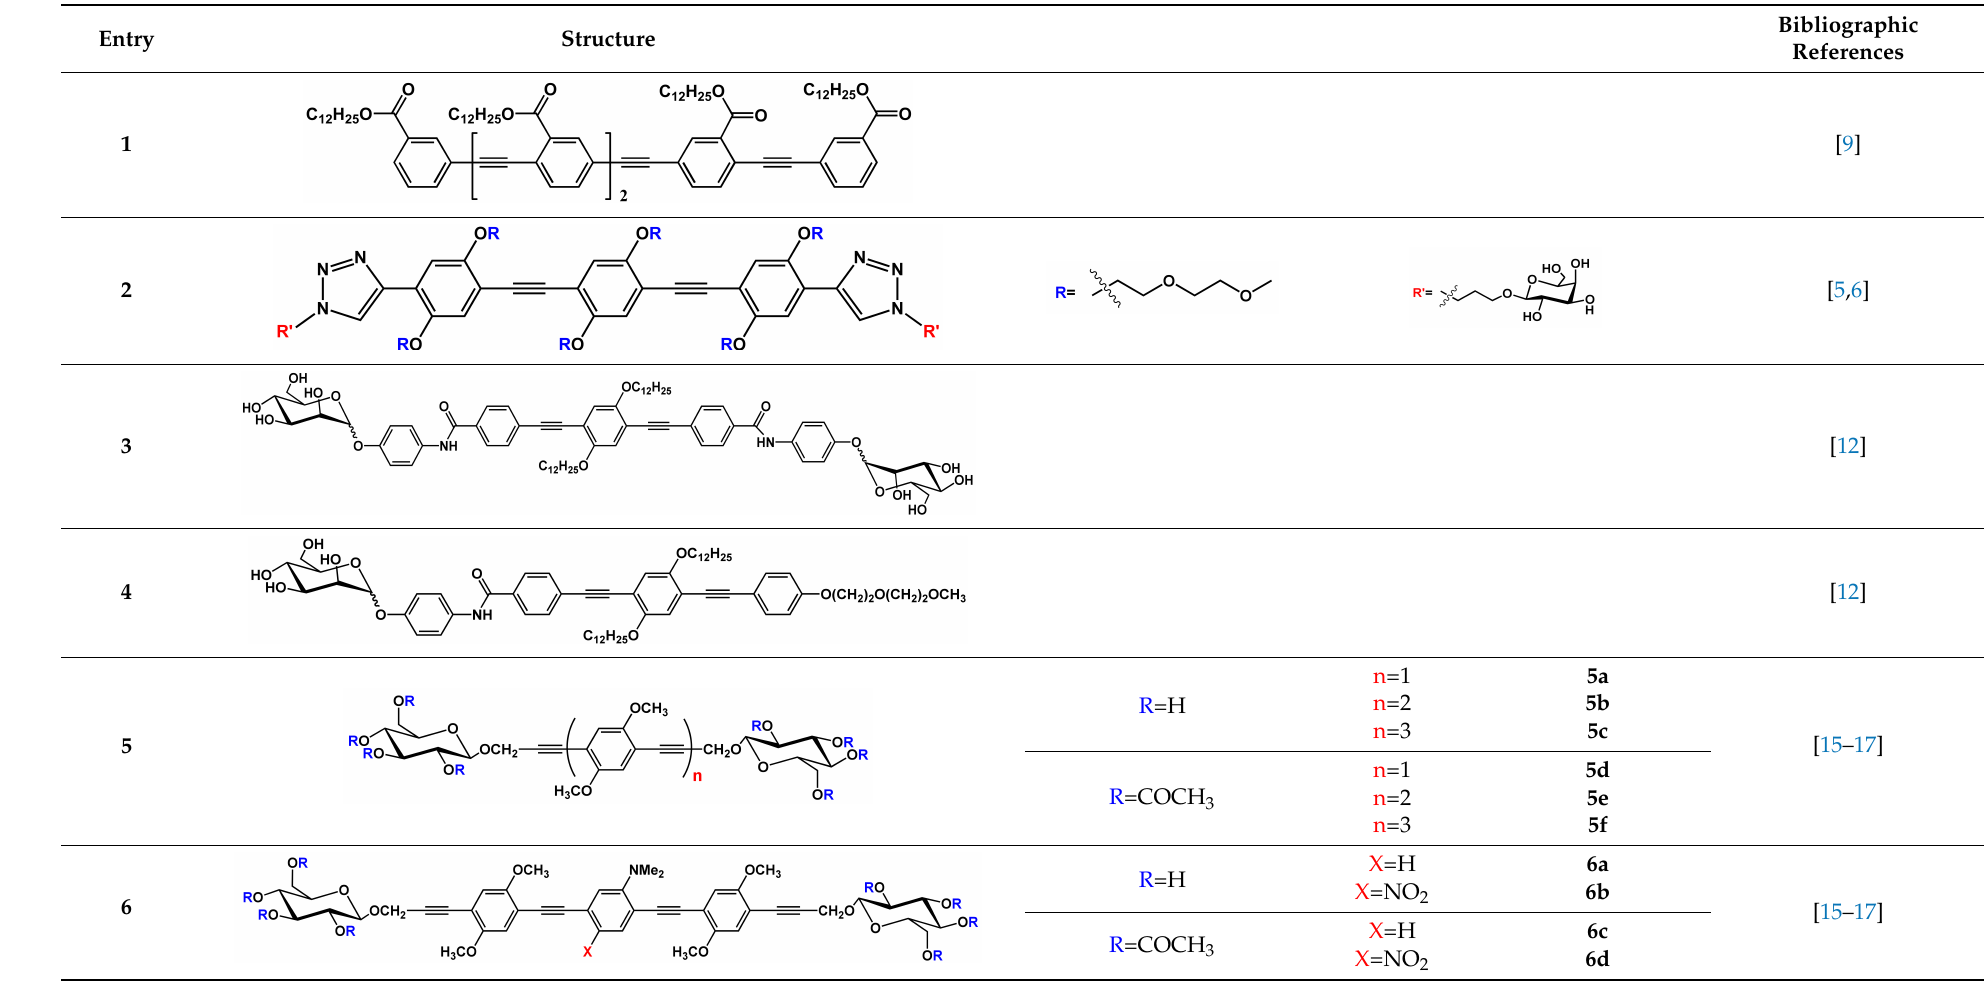
Table 1. Reported OPEs and their bibliographic